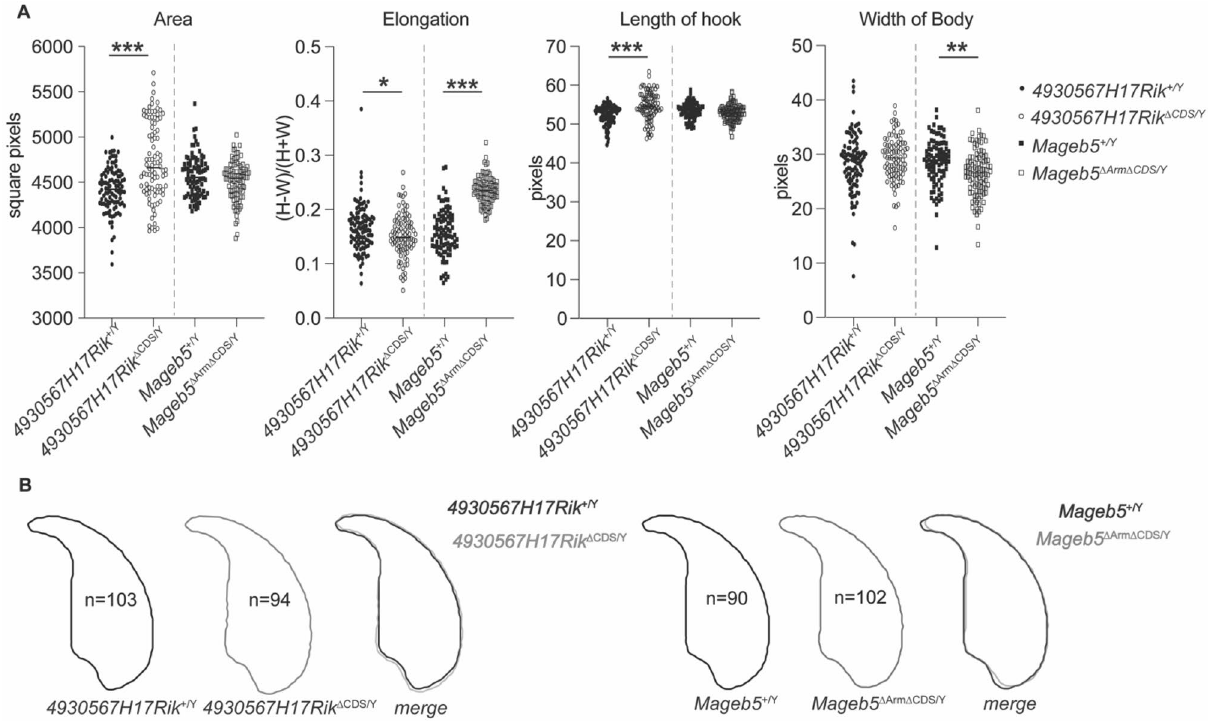
Figure 4. 4930567H17Rik ∆CDS/Y and Mageb5 ∆Arm∆CDS/Y mice display altered sperm morphology. ( A ) Sperm morphology characteristics calculated from assessment of DAPI images processed with a custom plugin to ImageJ 22 . All data were compared using an unpaired two-tailed t-test between 4930567H17Rik +/Y versus 4930567H17Rik ∆CDS/Y and Mageb5 +/Y versus Mageb5 ∆Arm∆CDS/Y . * p < 0.05 **p < 0.001, ***p < 0.0001. Additional parameters are shown in Fig S7. ( B ) Averages traces and shaded overlays of sperm head morphology from each genotype. Number of sperm assessed are shown inside each respective outline. Representative individual sperm nuclei are also shown in Fig